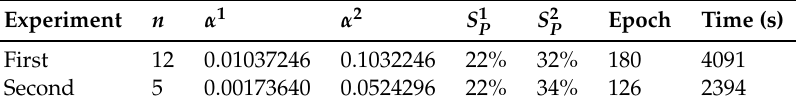
Table 1. Hyperparameters of the proposed SAE network.